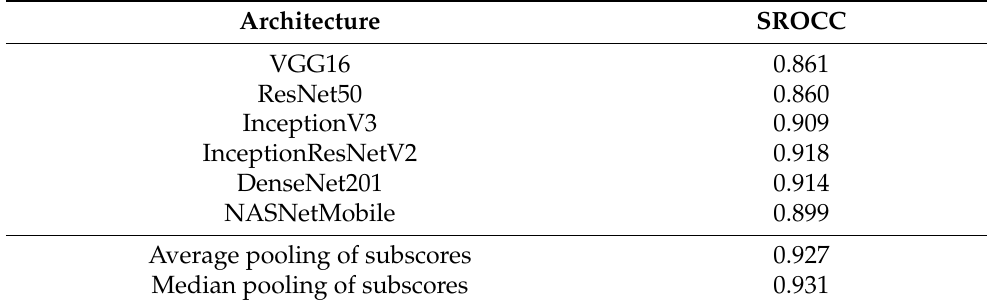
Table 3. Base CNN and decision fusion comparison on KonIQ-10k [4]. Median SROCC values were measured over 100 random train–validation–test